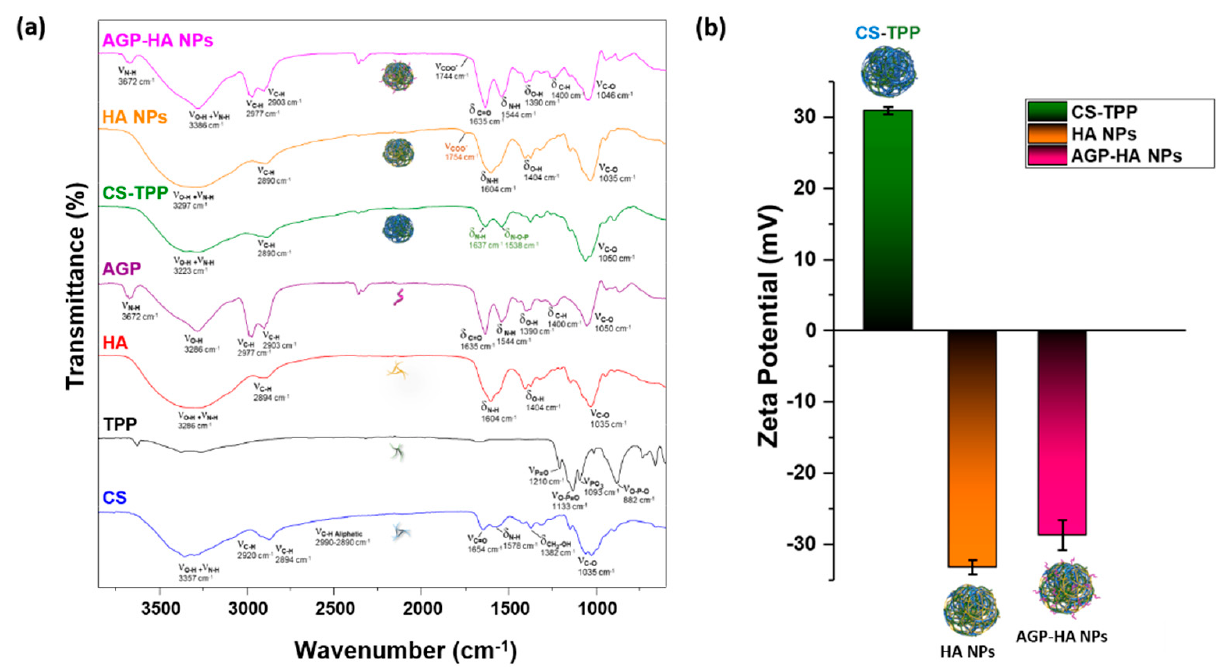
Figure 2. ( a ) FT-IR spectra and ( b ) zeta potential of chitosan-pentasodium tripolyphosphate Figure 2. ( a ) FT ‐ IR spectra and ( b ) zeta potential of chitosan ‐ pentasodium tripolyphosphate (CS ‐ TPP), hyaluronic acid nanoparticles (HA NPs), and α 1 ‐ acid glycoprotein ‐ conjugated hyaluronic acid nanoparticles (AGP ‐ HA NPs) and their separate component, confirming the successful incorpora ‐ tion of hyaluronic acid nanoparticles (HA NPs) components and the integration of α 1 ‐ acid glyco ‐ protein (AGP) with hyaluronic acid nanoparticles (HA NPs).